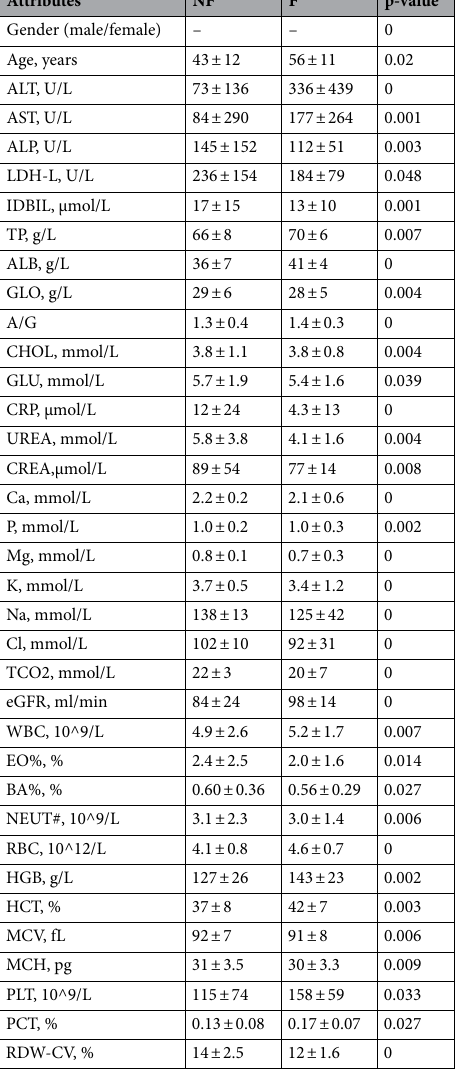
Table 1. Statistical analysis of attributes between group F and group NF with significant difference.